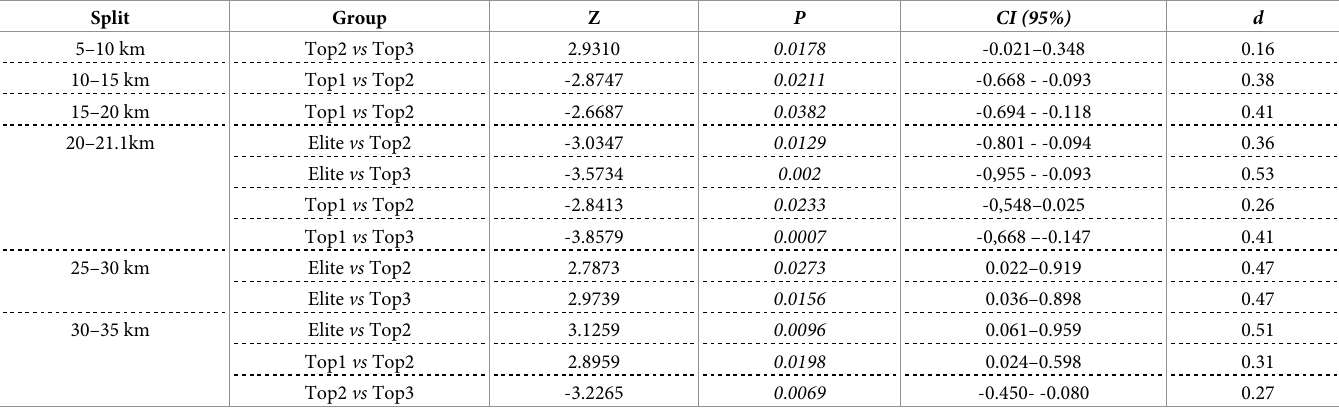
Table 3. Relationship between groups and average pace of competition in women.